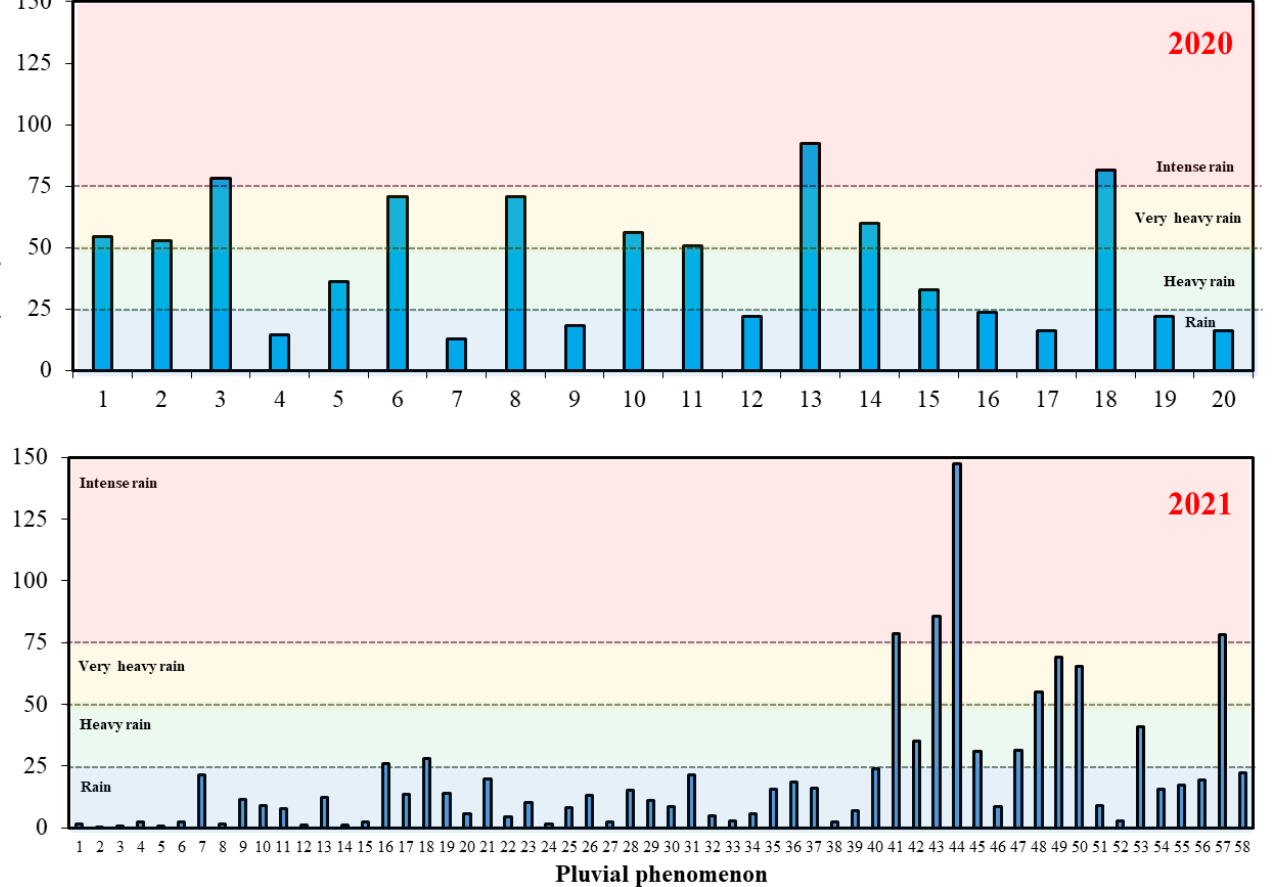
Figure 6. Rainfall event types in 2020 and 2021 recorded in the study area.